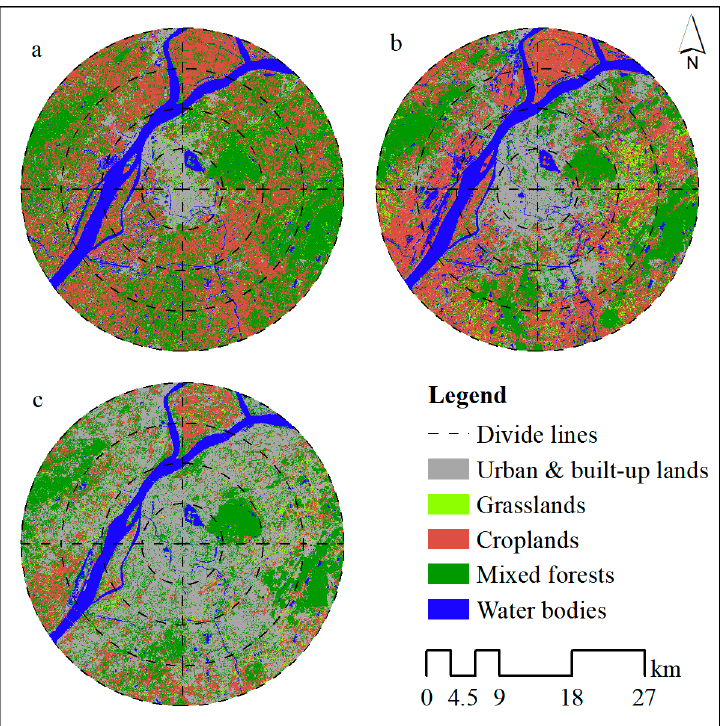
Figure 4. The land use/land cover classification maps covering the majority of the urban area in Nanjing in (a) 1985, (b) 2000, and (c) 2015.